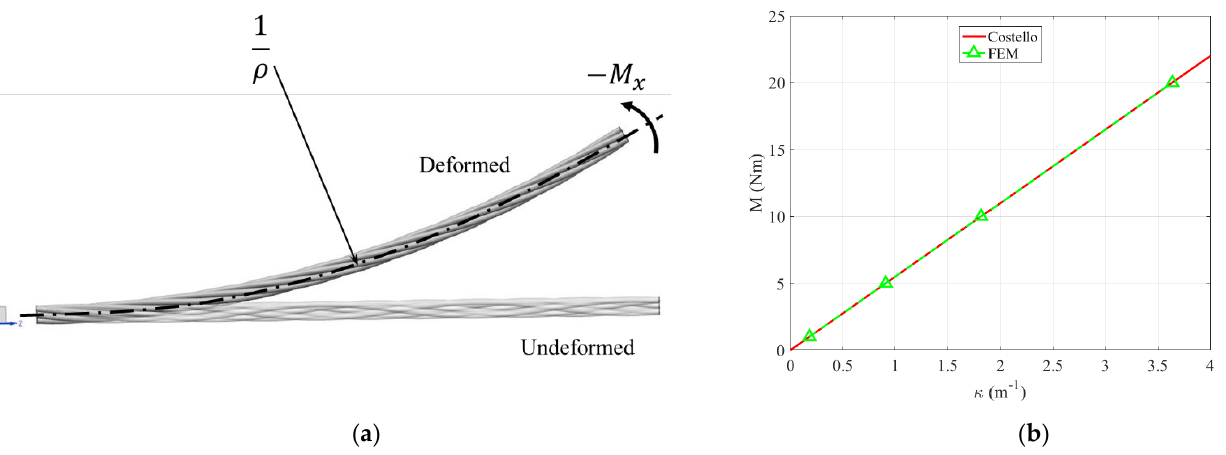
5 Nm, 10 Nm and 20 Nm, respectively.